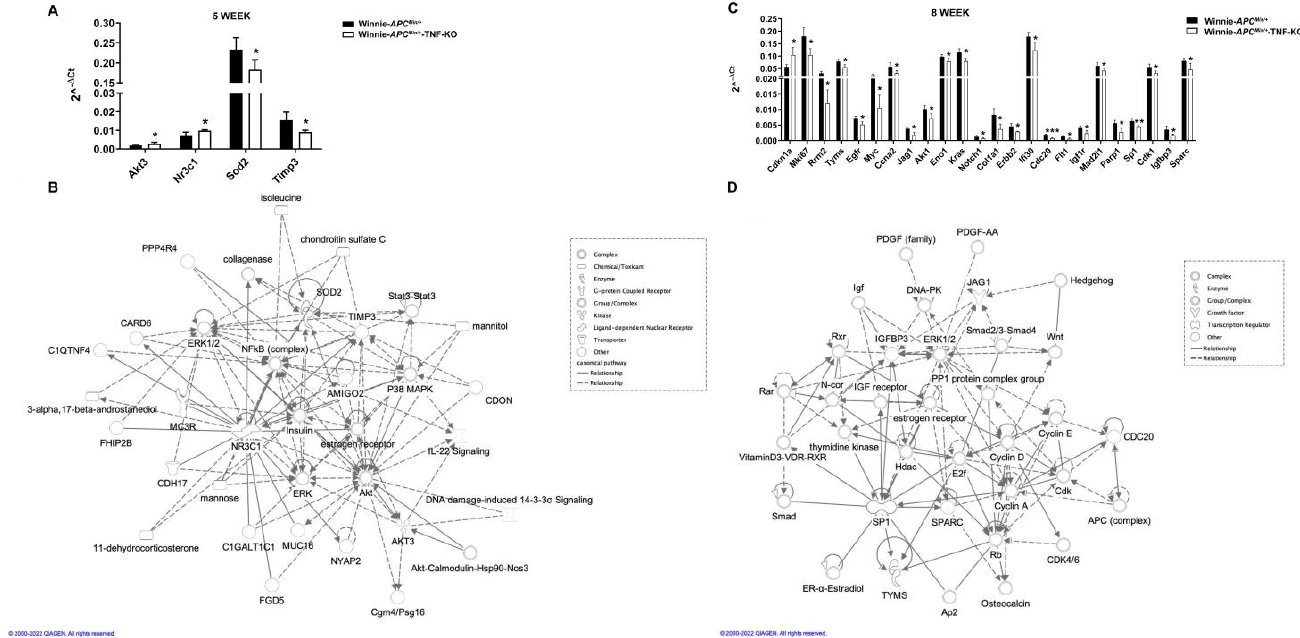
Figure 3. TNF-independent molecular profiling of distal colon from Winnie- APC Min/+ mice during CAC progression. Real-time quantification of Winnie- APC Min/+ (black bars) and Winnie- APC Min/+ - TNF-KO mice (white bars) mRNA expression at 5 weeks ( A ) and 8 weeks ( B ) using pre-custom plates for colorectal cancer (n = 4 animals/group). Histograms represent the mean ± SEM. * p < 0.05, ** p < 0.01, *** p < 0.001. Network analysis of the differential expressed genes at 5 weeks ( C ) and 8 weeks ( D ). The network was algorithmically constructed by IPA software based on the functional and biological connectivity. TNF: tumor necrosis factor; CAC: colitis-associated cancer; IPA: ingenuity pathway analysis.